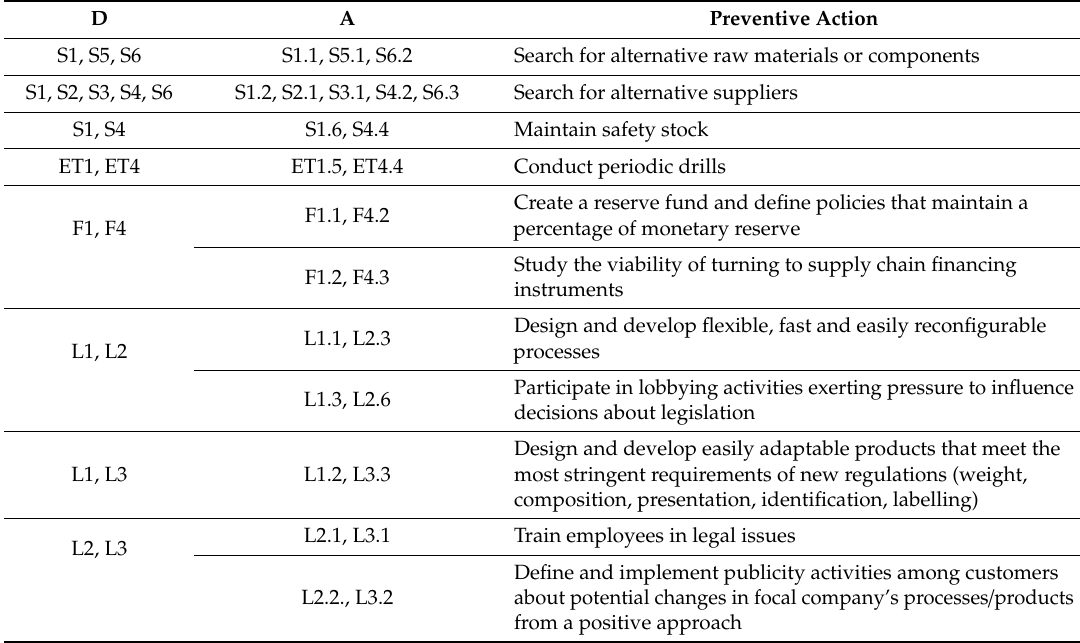
Table 10. Preventive actions that apply to multiple disruptive